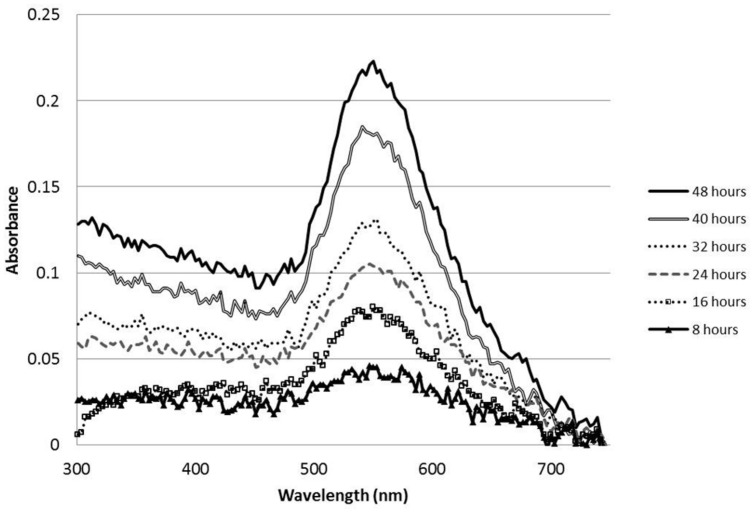
UV-Visible spectral timecourse of gold nanoparticles formed from 200 μl reactions comprising 0.1 mg MBP TMV mixed and shaken at 100 rpm with 3 mM potassium tetrachloroaurate.